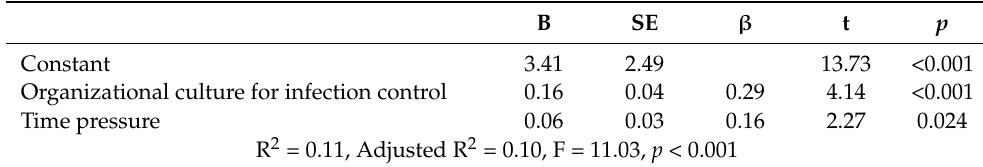
Table 4. Factors influencing Nursing Practice of Infection Control ( N = 183). B SE β t p Constant 3.41 <0.001 Organizational culture for infection control 0.16 <0.001 Time pressure 0.06